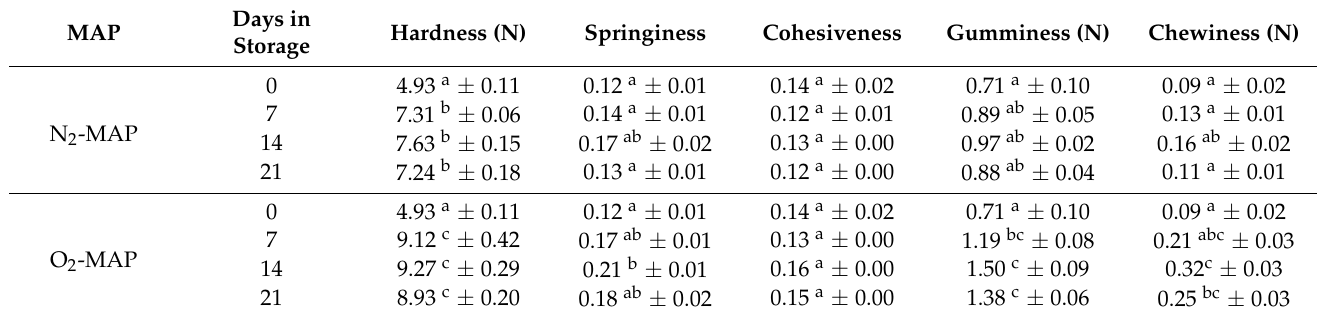
Data are expressed as means ± SEM ( n = 3). Lowercase superscript letters (a to c) in the same column indicate significant differences between samples ( p < 0.05). O 2 -MAP with 70% oxygen [O 2 ] + 30% carbon dioxide (CO 2 ) and N 2 -MAP with 70% nitrogen (N 2 ) + 30% carbon dioxide [CO 2 ].